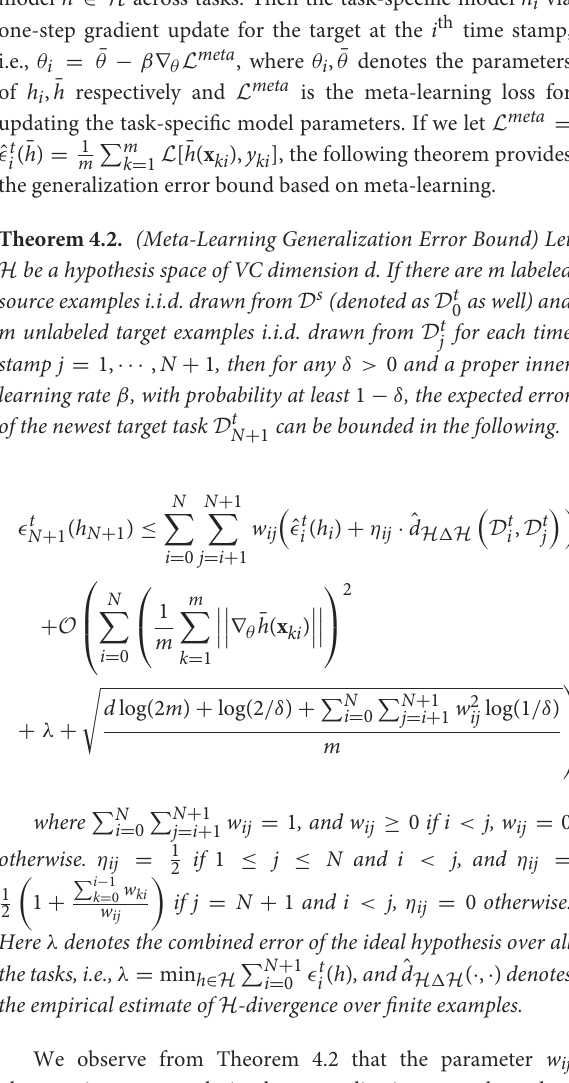
can be bounded N 1 +